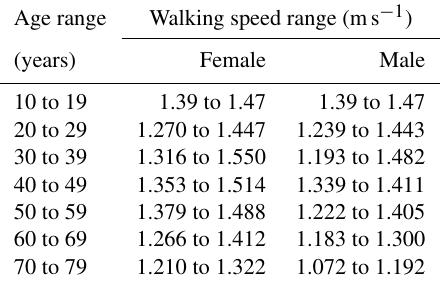
Table 2. Ranges of walking speeds for the pedestrian agents located in dry zones according to their age and gender (Toor et al., 2001; Mohler et al., 2007; Bohannon and Andrews,